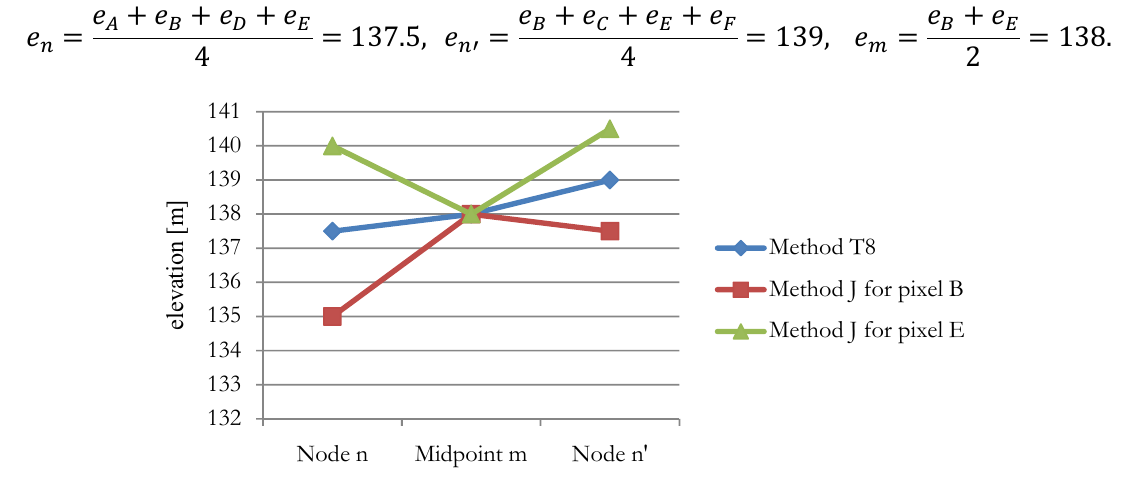
Figure 4. Elevations of the nodes and lengths of the common border.